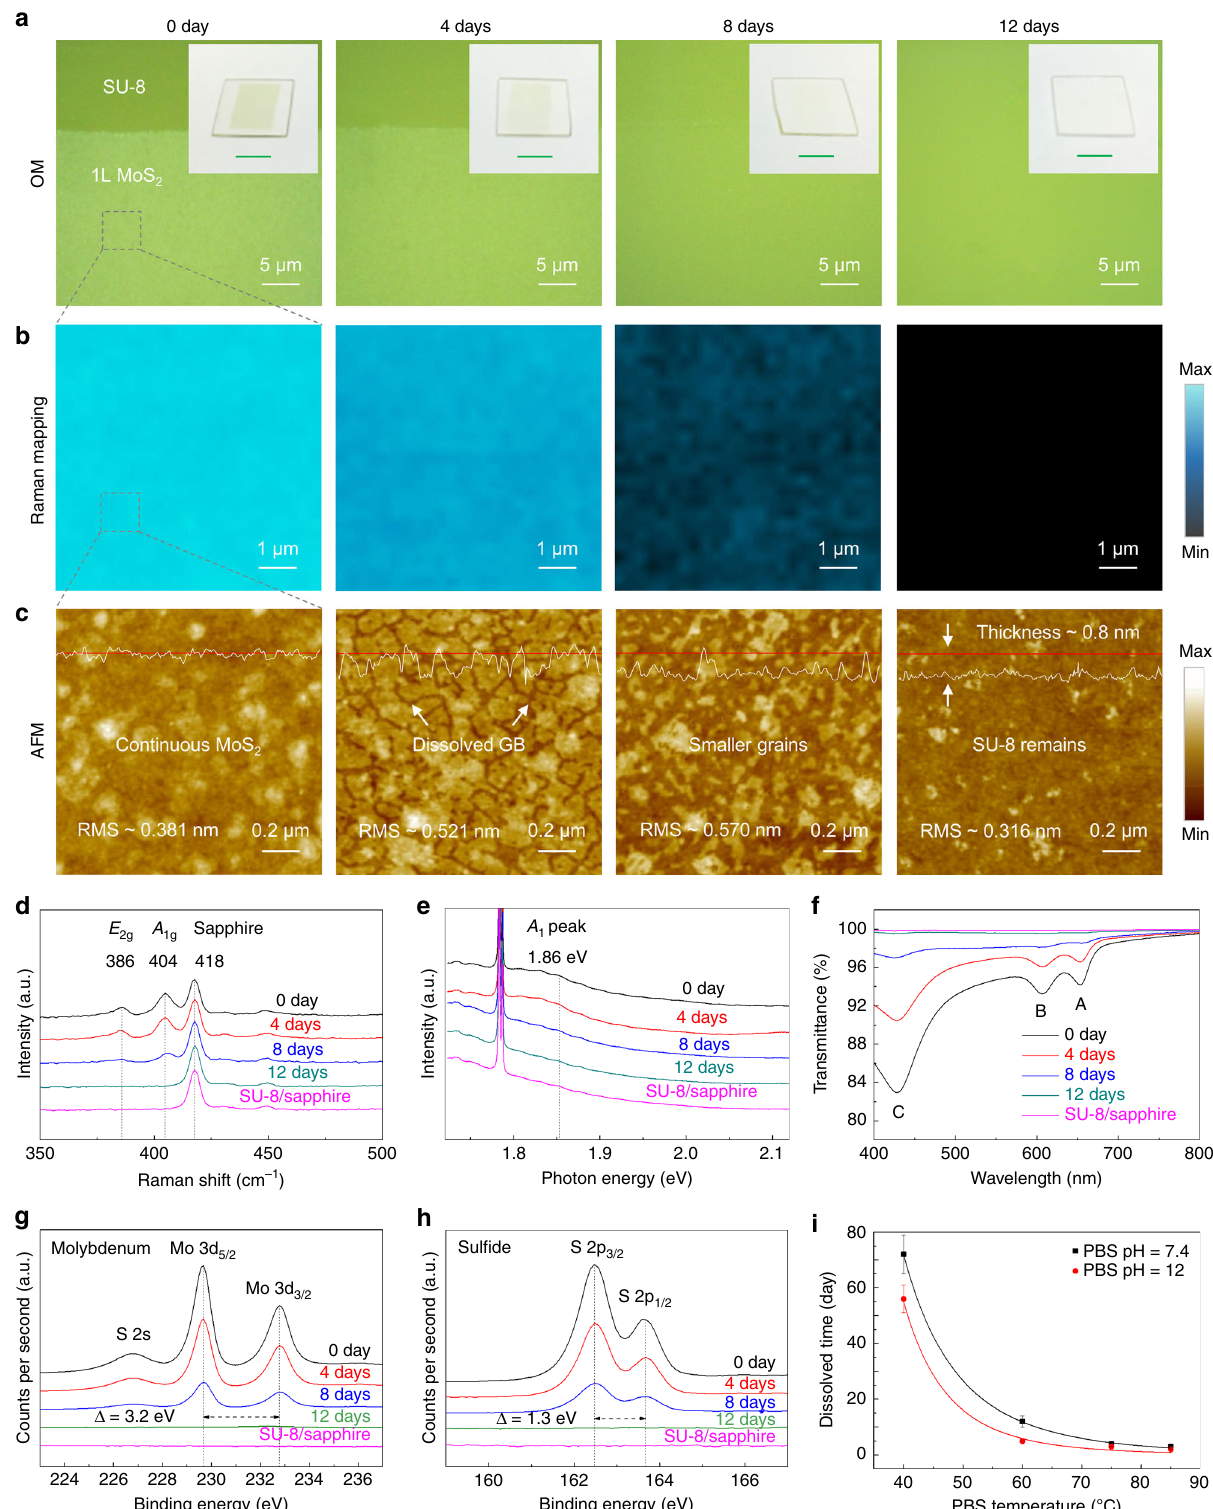
Fig. 2 Morphological and structural evolution of continuous monolayer MoS 2 fi lms with different dissolution times in PBS solution. a – c OM ( a ), Raman A 1g intensity mapping ( b ), and AFM ( c ) images of LPCVD-grown polycrystalline monolayer MoS 2 (grain size ~200 nm) immersed in a PBS solution (pH 7.4) at 60 °C with different dissolution times (0 – 12 days). Insets are the corresponding optical images of the dissolved MoS 2 monolayers on SU-8/sapphire substrates (scale bar is 5 mm). d – h Time-dependent Raman ( d ), PL ( e ), transmittance ( f ), and X-ray photoemission spectroscopy ( g , h ) spectra of the dissolved MoS 2 monolayers. i Temperature-dependent and pH-dependent speed at which the MoS 2 monolayer dissolved in PBS solution. Error bars of the experimental data represent standard error of